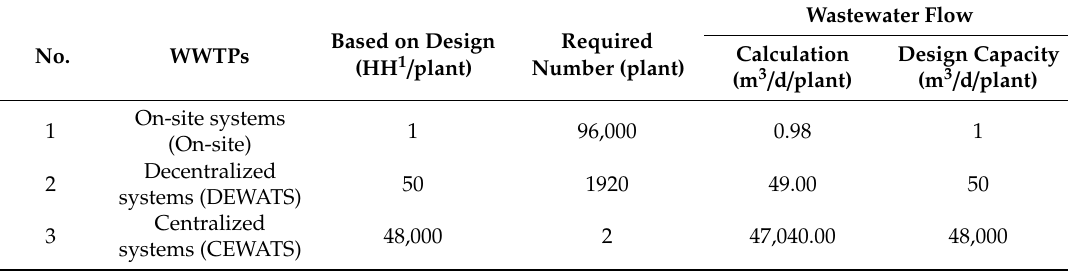
Table 2. The capacity and the required number of